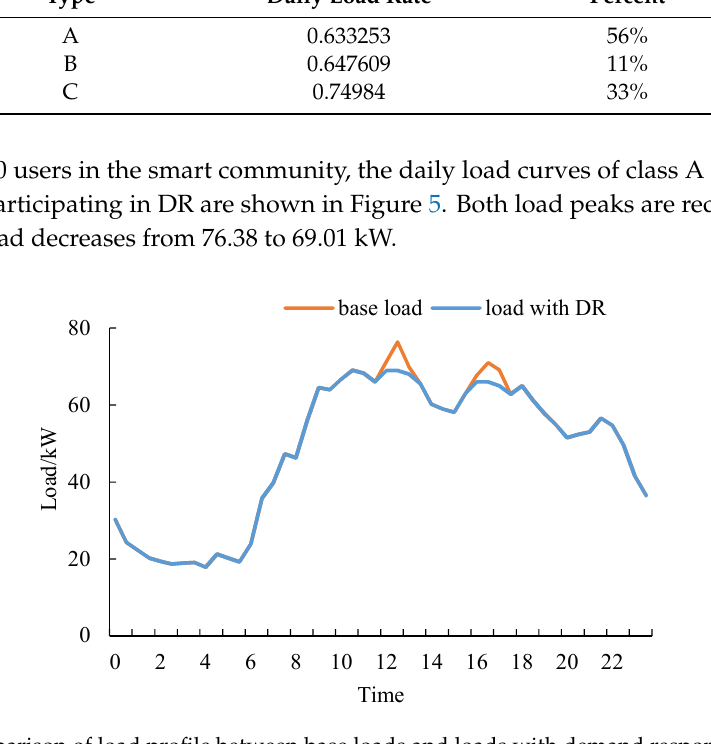
Figure 5. Comparison of load profile between base loads and loads with demand response (DR) taken into account.